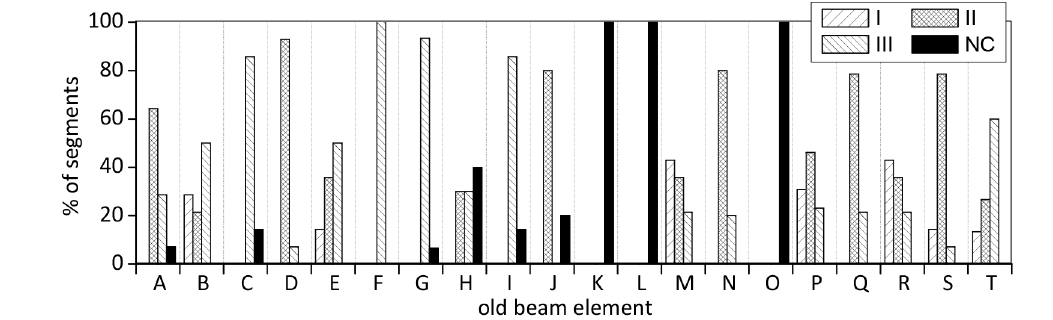
Fig. 3. Percentage distribution of segments in the old beams included in each visual grading class (UNI 11119:2004) considering damage due to external causes